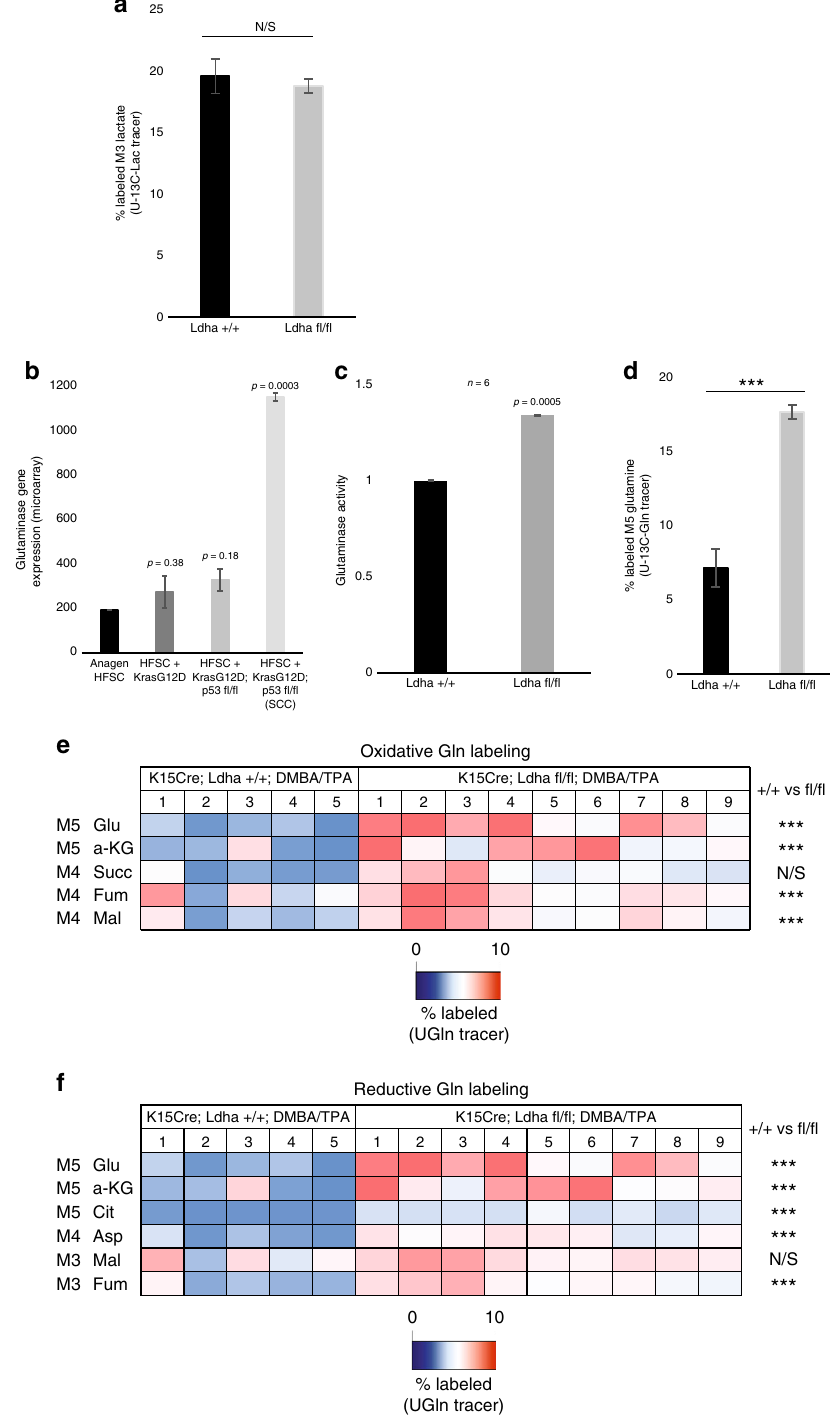
Fig. 7 Glutamine uptake and metabolism are elevated Ldha-null tumors. a Percentage of M3 lactate in Ldha + / + vs. fl / fl tumors from mice injected with [U- 13 C 3 ]lactate 15 min prior to tumor harvesting and metabolite extraction. Student ’ s paired t test was performed, ∗ P < 0.05; ∗∗ P < 0.01; ∗∗∗ P < 0.001; NS, not signi fi cant; n = 12. b Glutaminase mRNA levels in HFSCs at various stages of tumorigenesis. Each bar represents n = 3 mice per condition. Shown as mean ± SEM. Student ’ s paired t test is shown for each condition vs. anagen HFSCs. c Glutaminase activity in lysate from wild-type and Ldha -null tumors. Each bar represents the relative glutaminase activity signal for each genotype type, where n = 3 mice per genotype. Shown as mean ± SEM. Student ’ s paired t test was performed, P < 0.05 shown for wild-type vs. knockout tumors. d Percentage of M5 glutamine in Ldha + / + vs. fl / fl tumors from mice injected with [U- 13 C 5 ]glutamine 15 min prior to tumor harvesting and metabolite extraction. Student ’ s paired t test was performed, ∗ P < 0.05; ∗∗ P < 0.01; ∗∗∗ P < 0.001; NS, not signi fi cant; n = 12. e – f Heatmaps depict percentage of TCA cycle intermediate isotopomers in oxidative and reductive glutamine metabolism, respectively, in tumors with the indicated genotypes. Animals were IP injected with [U- 13 C 5 ] glutamine 15 min prior to tumor harvesting. Student ’ s paired t-test was performed; ∗ P < 0.05; ∗∗ P < 0.01; ∗∗∗ P < 0.001; NS, not signi fi cant; n =